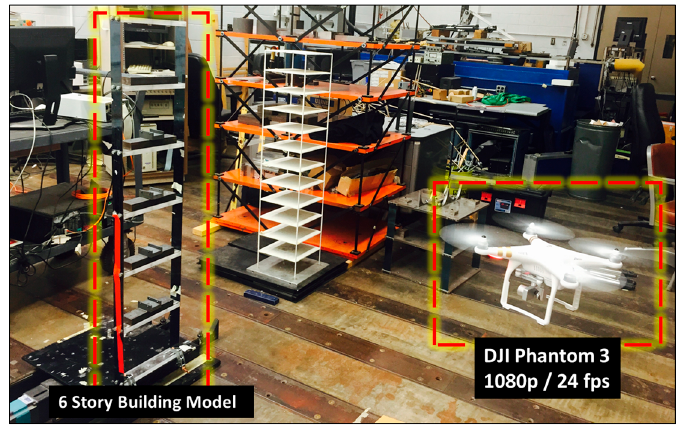
Figure 5. Experimental setup.